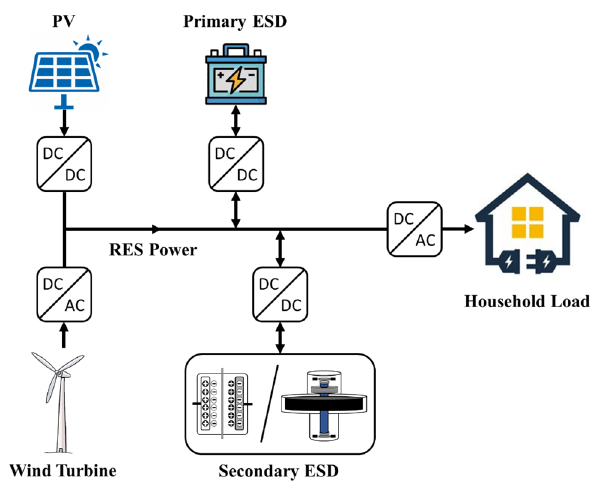
Figure 1. Parallel active HESS configuration in a RES household-prosumer system.